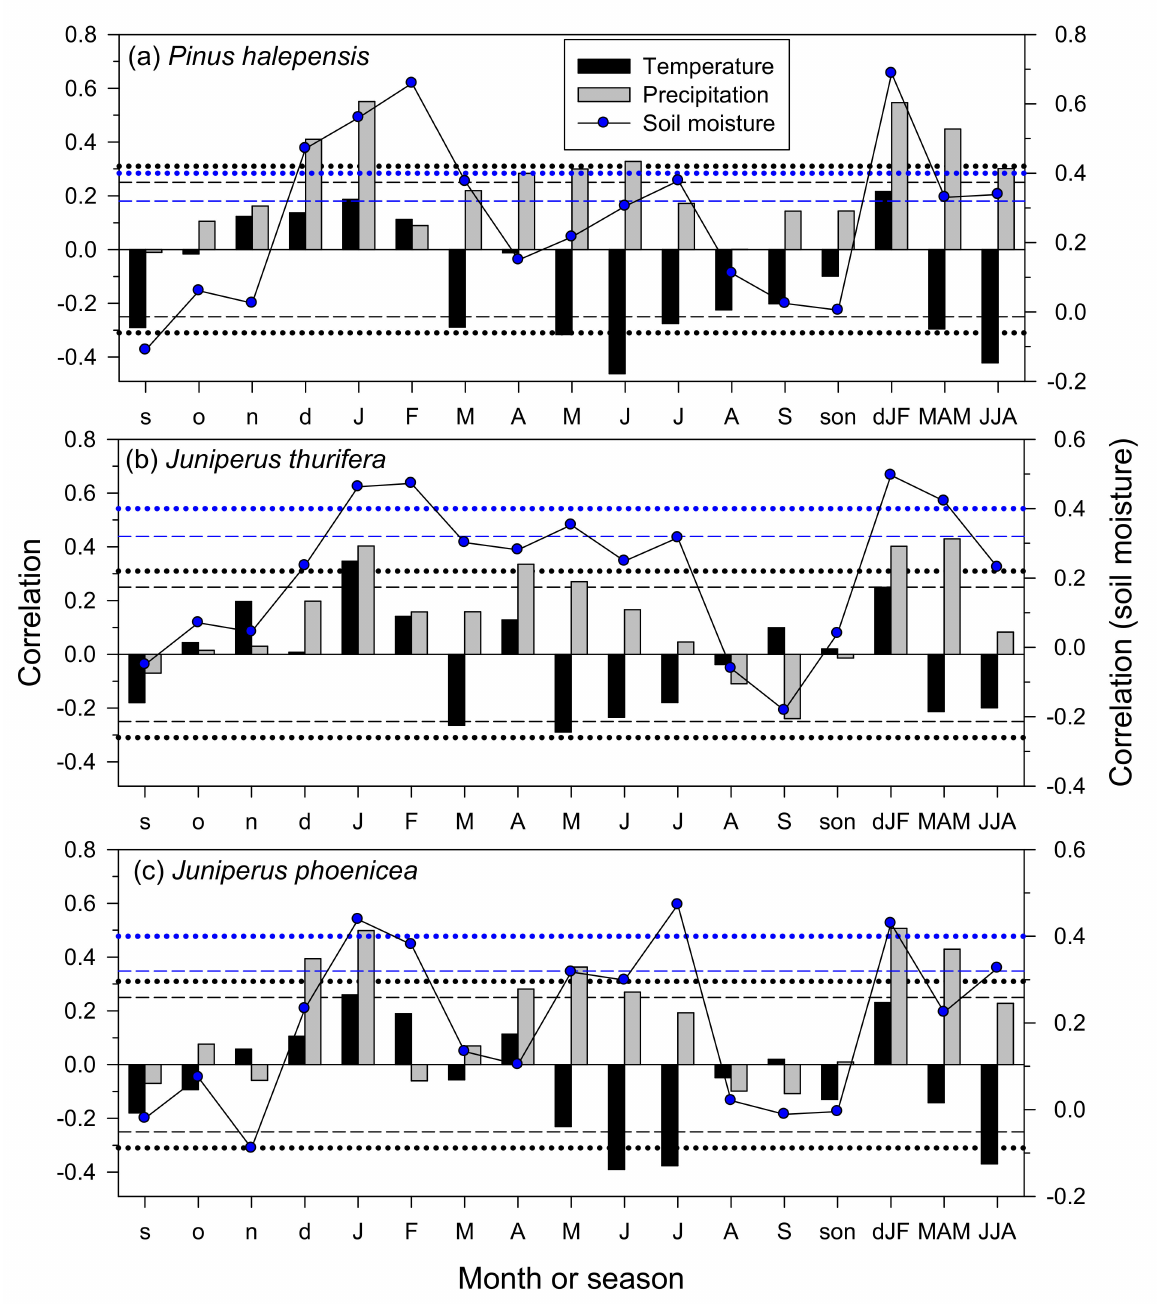
Figure 6. Monthly and seasonal climate–growth relationships of three species studied at the very dry site. Horizontal dashed and dotted lines indicate the 0.05 and 0.01 significance levels, respectively. Note the different scales for the soil moisture (blue symbols with lines, right y -axes) and their significance levels (blue dashed and dotted lines). Months of the prior and current years are abbreviated using lowercase and uppercase letters,